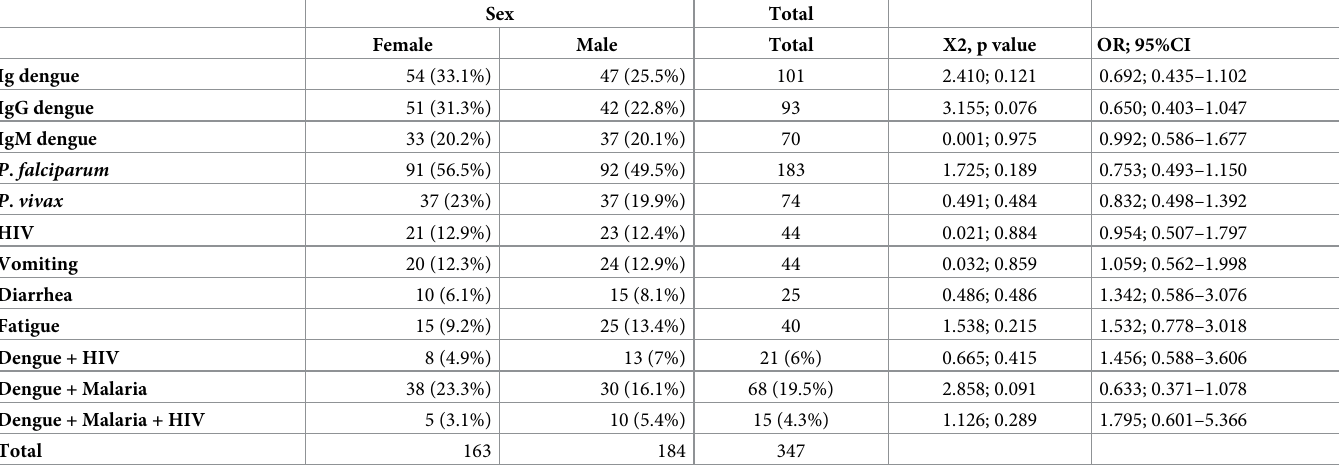
Table 3. Sex distribution of the different infections (active and past) and symptoms in the study population.